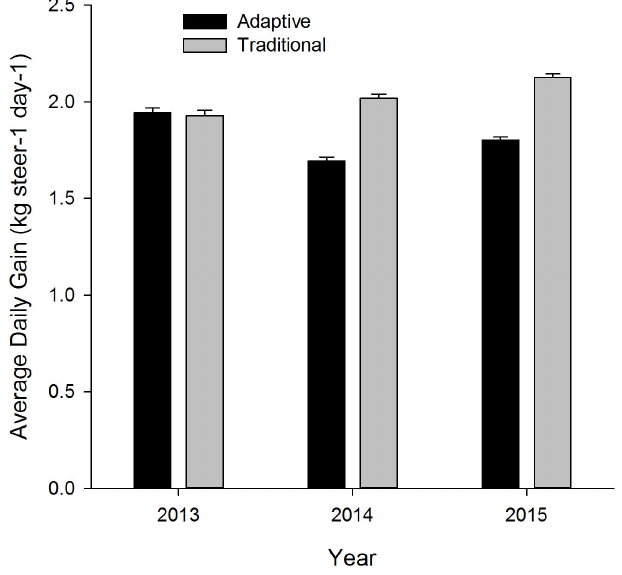
Fig. 4 . Mean annual weight gains of cattle in collaborative adaptive rangeland management (CARM) compared to traditionally managed treatment (TRM). Weight gains in 2013 (pretreatment baseline) did not differ between CARM and TRM pastures ( P = 0.39). Gains in CARM were 16% lower than TRM in 2014 and 15% lower in 2015 ( P -values < 0.0001). These data were available to stakeholders at the end of each grazing season, while time-lags limited vegetation and grassland bird monitoring data availability.